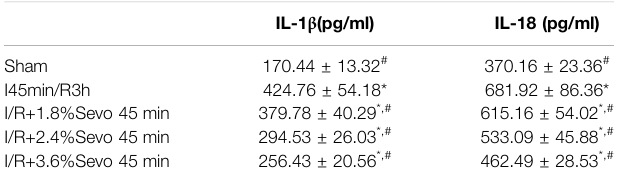
TABLE4| EffectsofSevo fl uraneatdifferentconcentrationsonthereleaseofIL-1 β and IL-18 in myocardial tissue after MIRI (n (cid:1)